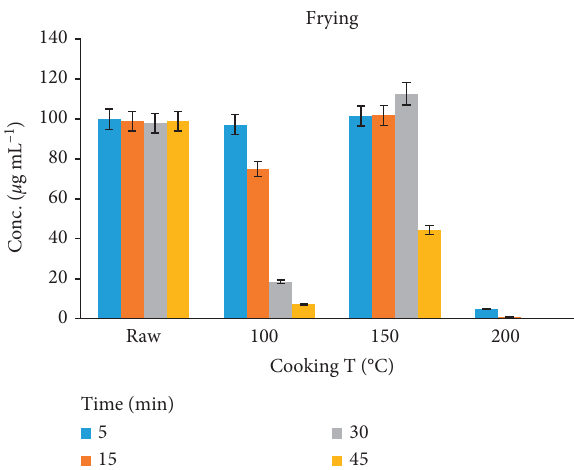
5: The effects of frying on the depletion of Amox residue within different temperatures and times from chicken